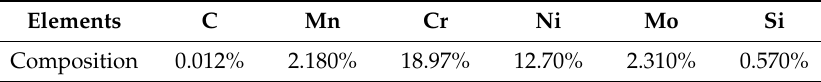
Figure 1. Welding experiment platform. ( a ) Structure diagram; ( b ) Physical diagram. Table 1. The chemical composition of welding wire.